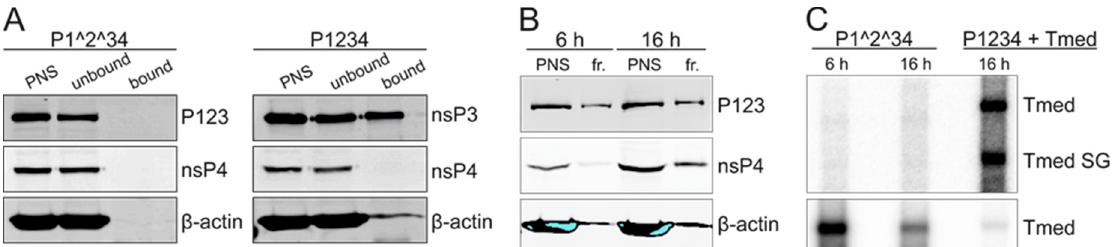
Figure 7. Exogenous template RNA is not replicated in vitro. ( A ) BSR cells were transfected with the polyprotein construct P1^2^34 or P1234 and cells were collected at 16 h post transfection followed by homogenization and HA-affinity capture. The HA tag was in nsP3. After PNS was incubated with HA-specific agarose beads, they were washed and boiled with Laemmli sample buffer. The presence of polyprotein P123, nsP3, nsP4, and β -actin in PNS as well as in unbound and bound fractions was studied by Western blotting. P123 and nsP3 were detected using an antibody against the HA tag; ( B ) BSR cells were transfected with the polyprotein construct P1^2^34, cells were collected at 6 or 16 h post transfection, and membranes were purified from PNS using flotation centrifugation. A Western blot analysis shows the presence of P123, nsP4, and β -actin in the PNS and membrane fractions (fr.); ( C ) IVRA was performed with the flotation fractions by adding 1 µg of Tmed in vitro transcript. As a control, replication activity from the endogenous template is shown for PNS prepared from BSR cells co-transfected with the P1234 and Tmed constructs. The lower panel shows the presence of exogenous Tmed transcript in the membrane fractions after the IVRA, detected by in-gel hybridization from the same gel using a probe specific to the plus-stranded